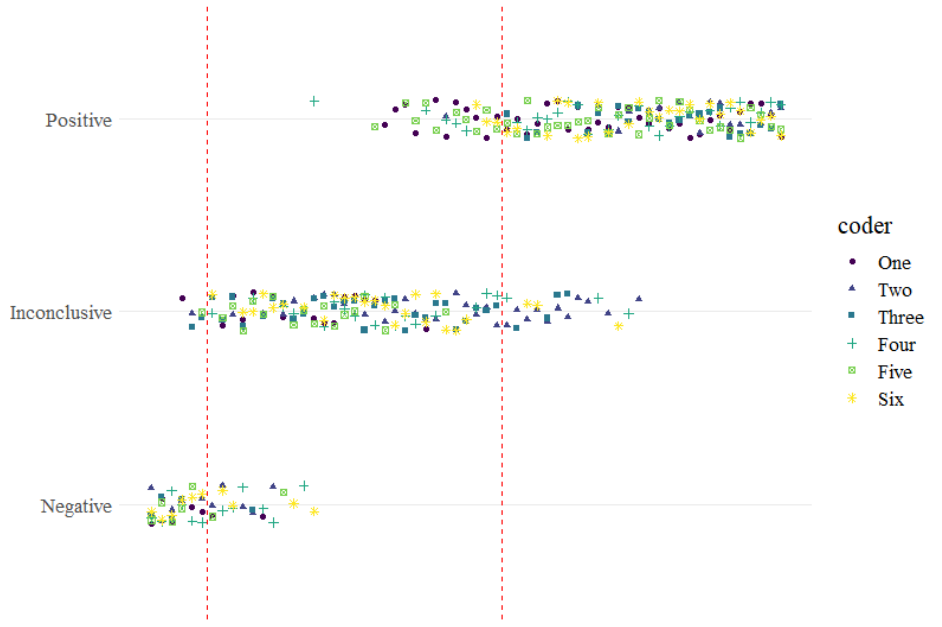
Note . The 63 papers are presented sequentially along the x-axis and each coder’s decision is presented on the y-axis (Positive, Inconclusive, Negative). Papers with most negative ratings are presented on the left-hand side, and papers with the most positive ratings are presented on the right. The red dashed lines indicate what category a particular paper was coded as when all the coders’ responses were taken into account: papers were coded as ‘Negative’ (leftmost) or ‘Positive’ (rightmost) when at least 4 coders coded it as falling into that category, and papers were coded as ‘Inconclusive’ (center) when the number of coders coding the paper as either positive/negative or inconclusive was equally split, (i.e., 3 coders in each